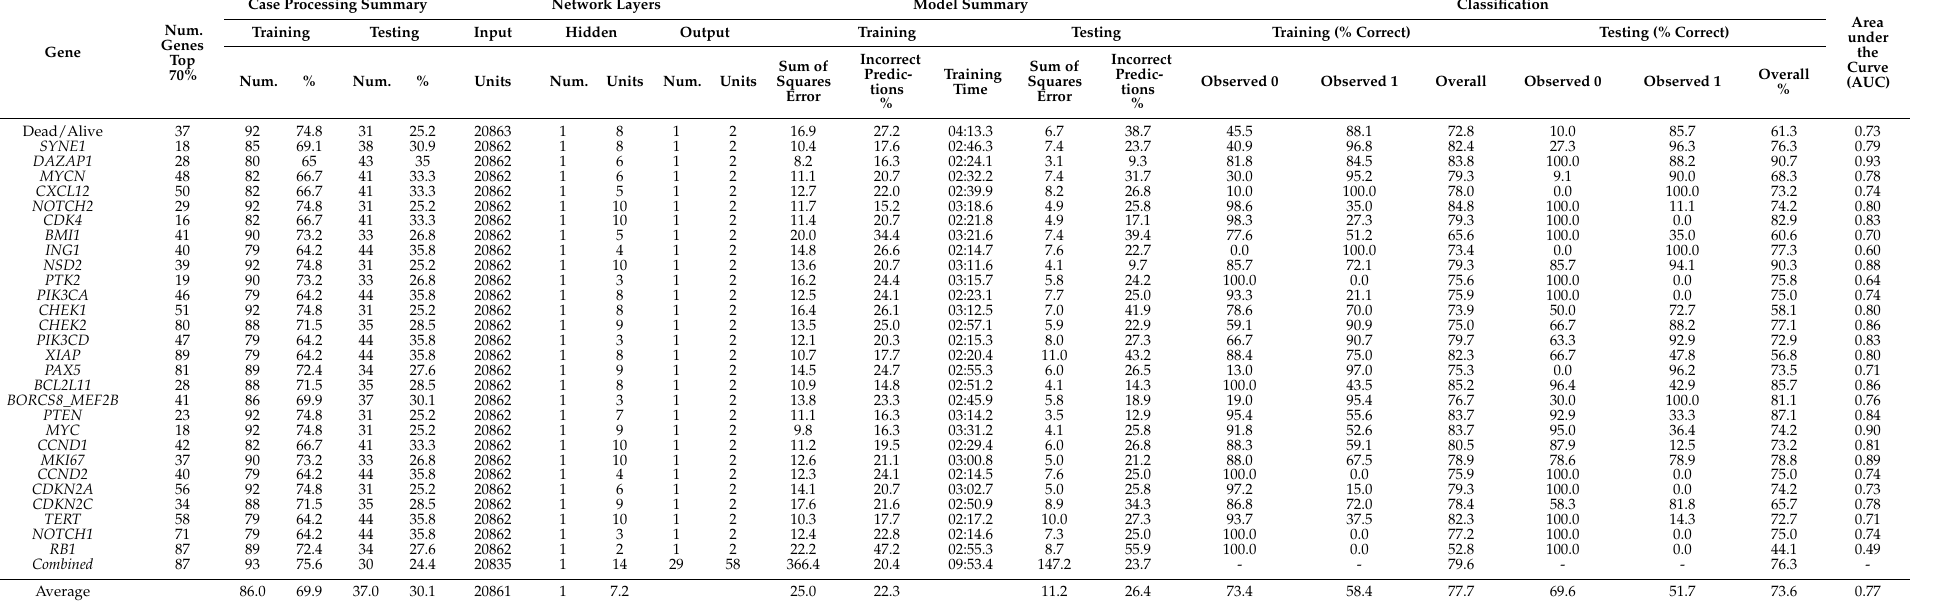
Table A2. Radial Basis Function Neural Network Analysis of Mantle Cell Lymphoma (Method